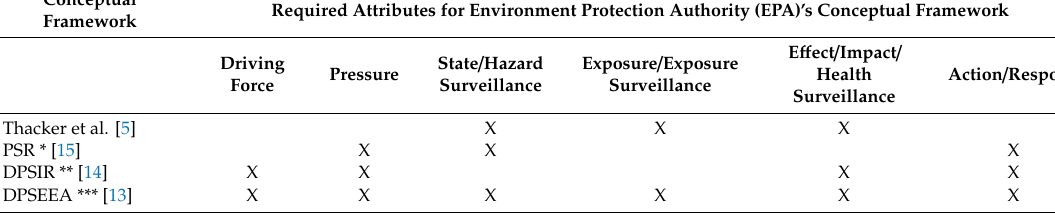
Table 1. Components of some conceptual